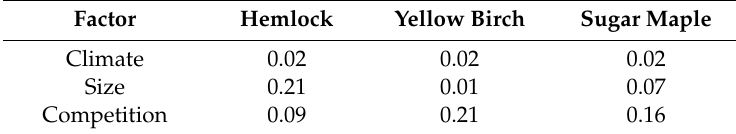
Table 4. Relative strength of contribution of climate, size, and competition to radial growth of three tree species in old-growth hemlock stand of mixed-northern hardwood forest in east–central New York: values indicate a mean increase in R 2 when the factor was added to simpler models of growth.